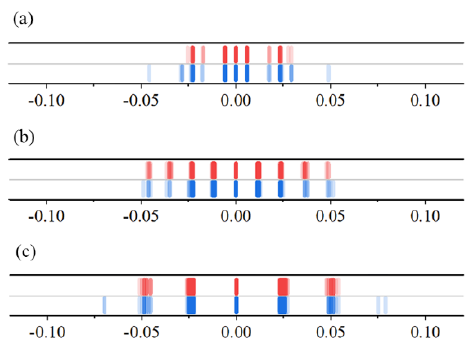
Figure 9. Schematic diagram comparing the numerical fluctuation frequency in the DSI under ω ≤ 1: ( a ) ω = 1/4; ( b ) ω = 1/2; ( c ) ω = 1 (red represents the STAA and blue represents the TDAA [11]).